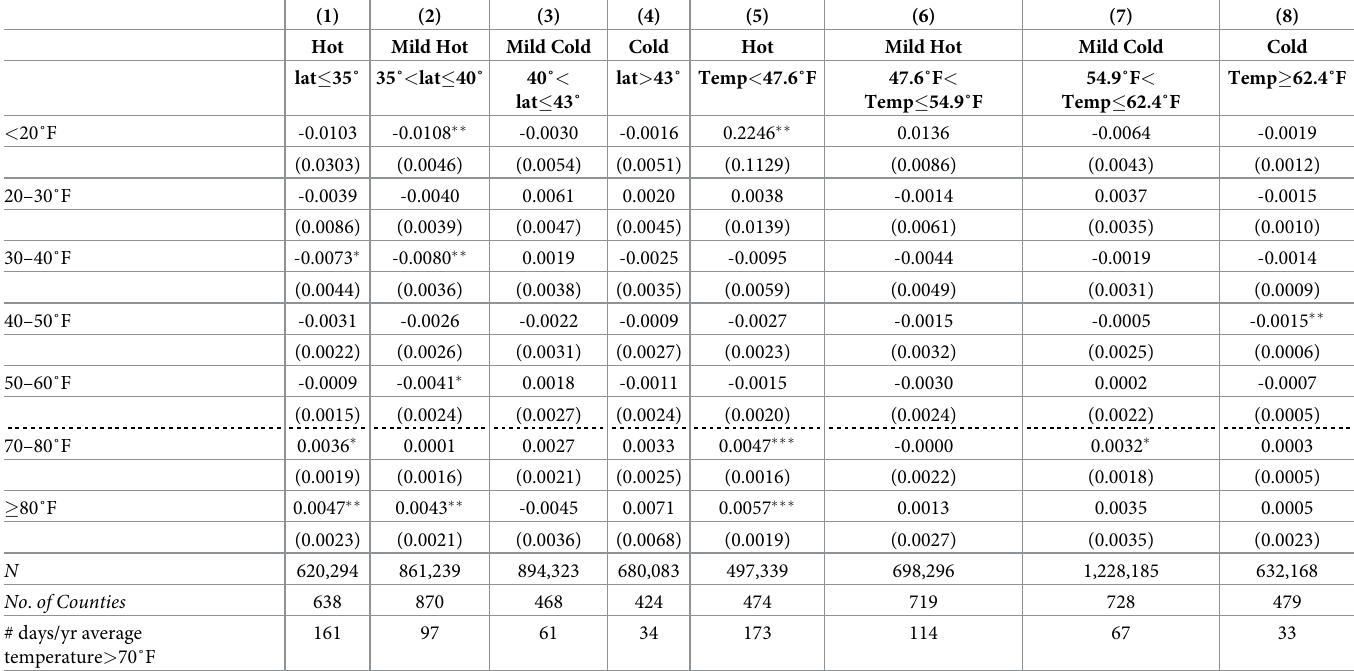
Table 6. Effect of temperature over previous 30 days on the probability of self-reported mental health difficulties: By climate